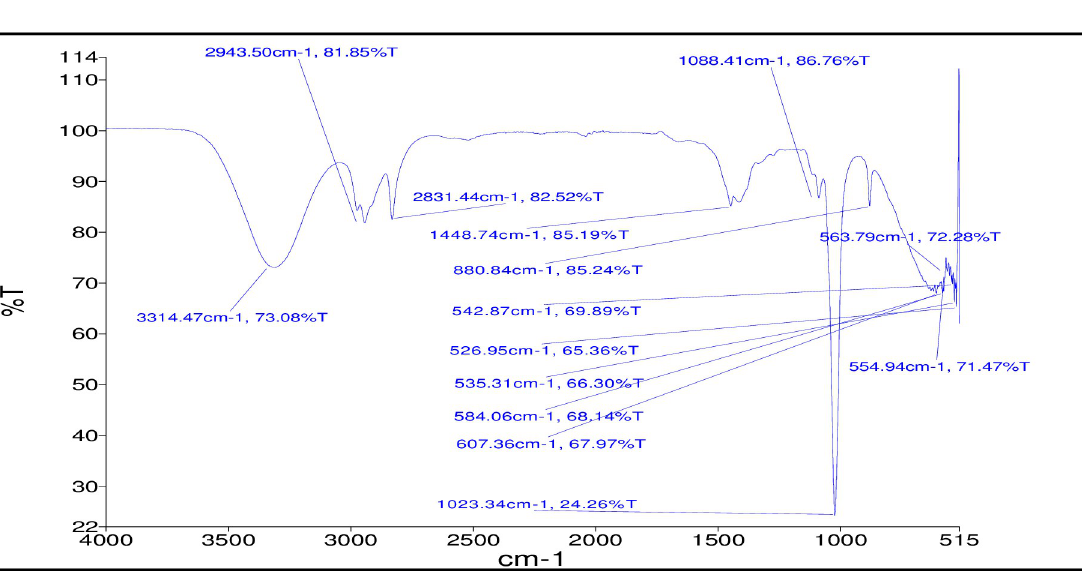
Molecular docking. NS3 protease’s three-dimensional crystal structure has been desig- nated for docking. At the N-terminal domain, the zinc-dependent serine protease NS3 prote-